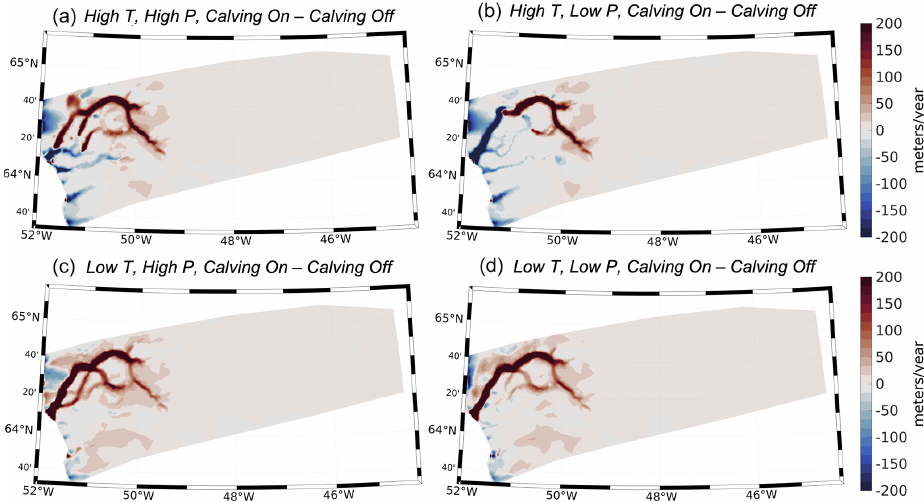
Figure 11. Simulated ice velocity differences between simulations with and without calving for each experiment over the time period 12 to 10ka. Red colors denote an increase in ice velocity for simulations with calving relative to simulations without calving. Blue colors denote a decrease in ice velocity for simulations with calving relative to simulations without